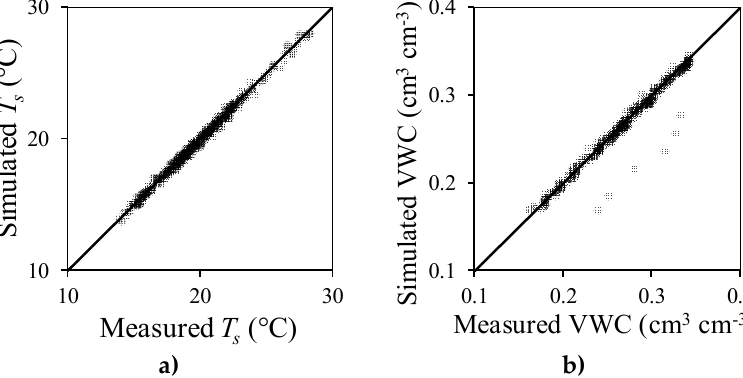
Figure 11. Comparison of the measured and the simulated values by the ICON model for (a) soil temperature and (b) volumetric water content.